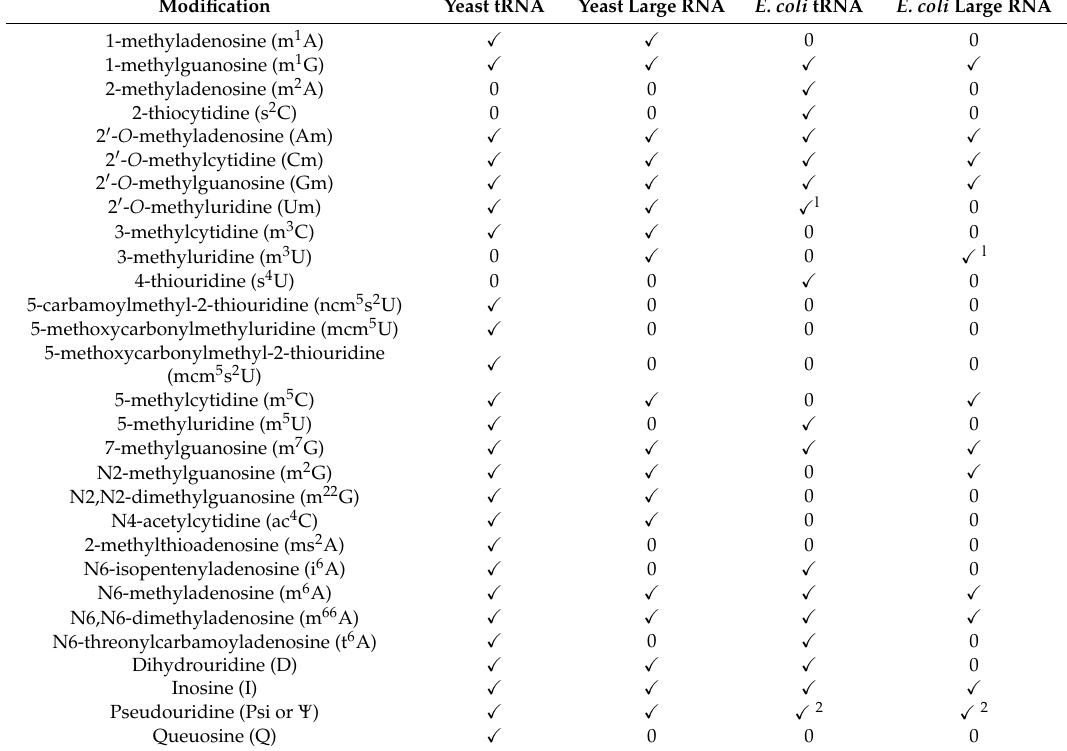
Table 1. Overview of modified nucleosides found in the respective RNA preparations from yeast ( S. cerevisiae ) and E. coli . Present: (cid:88) ; Absent: 0. Modification Yeast tRNA Yeast Large RNA E. coli tRNA E. coli Large